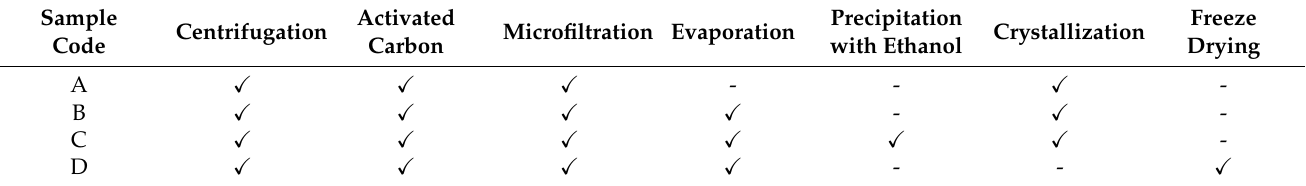
Table 1. Downstream approaches used in the